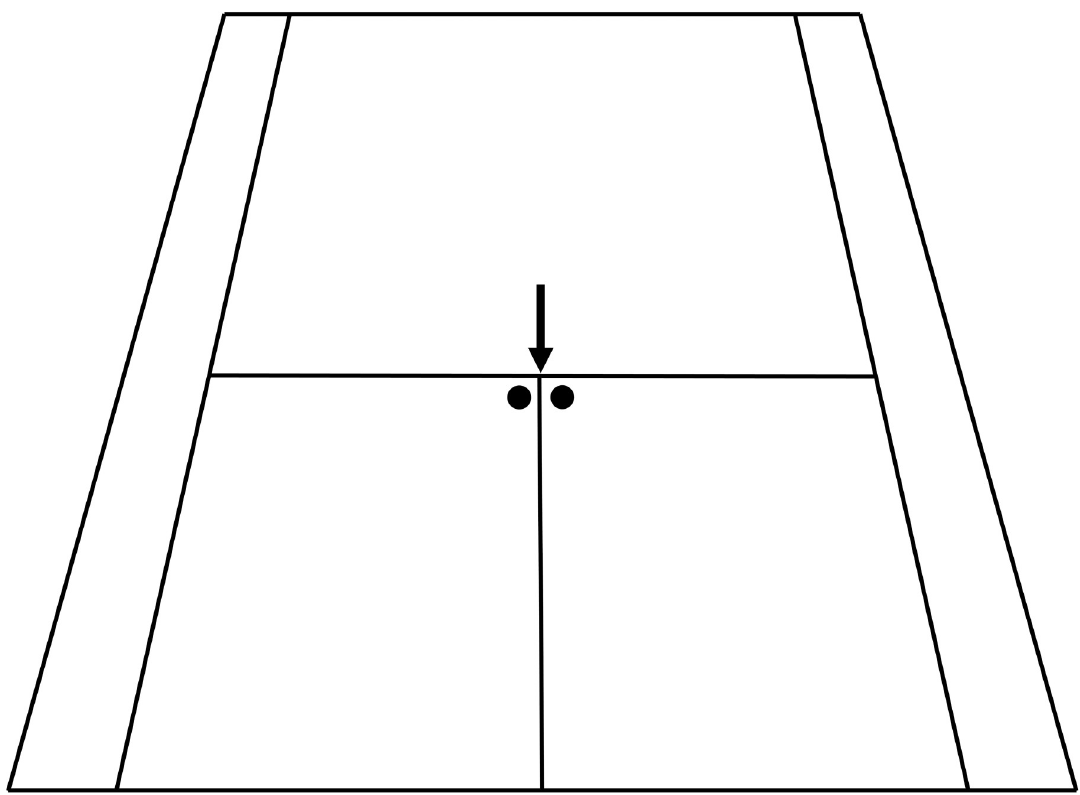
Fig 1. Illustration of target position for the serve. Target points for the serve at the opposite side of the court marked as black dots and starting point of the measurement marked with arrow. Left target point was served at from the right side of the baseline and right target point was served at from the left side of the